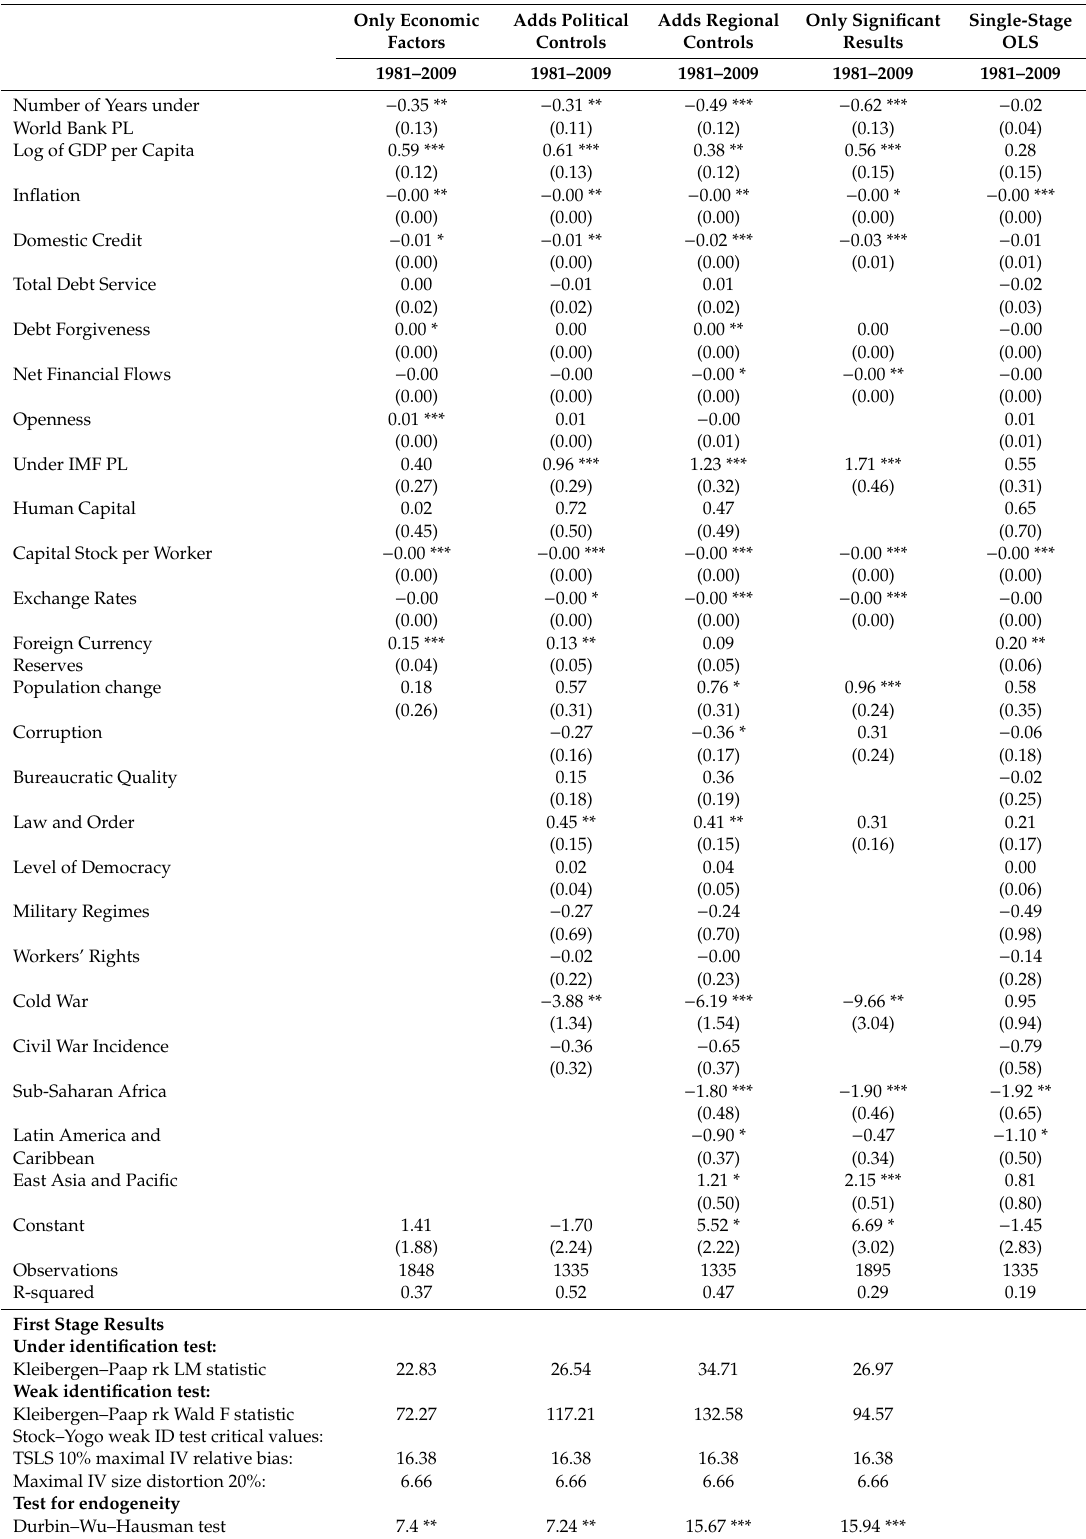
Table 2. Two-Stage Least Squares: World Bank Program Lending and Its E ff ects on Economic Growth, 1981–2009, All Developing